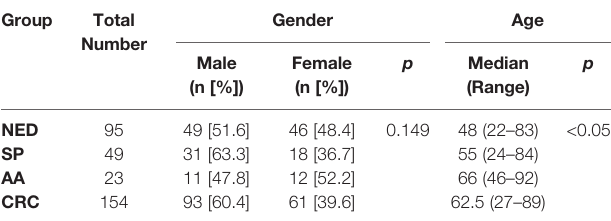
TABLE 1 | Characteristics of subjects enrolled in this study.